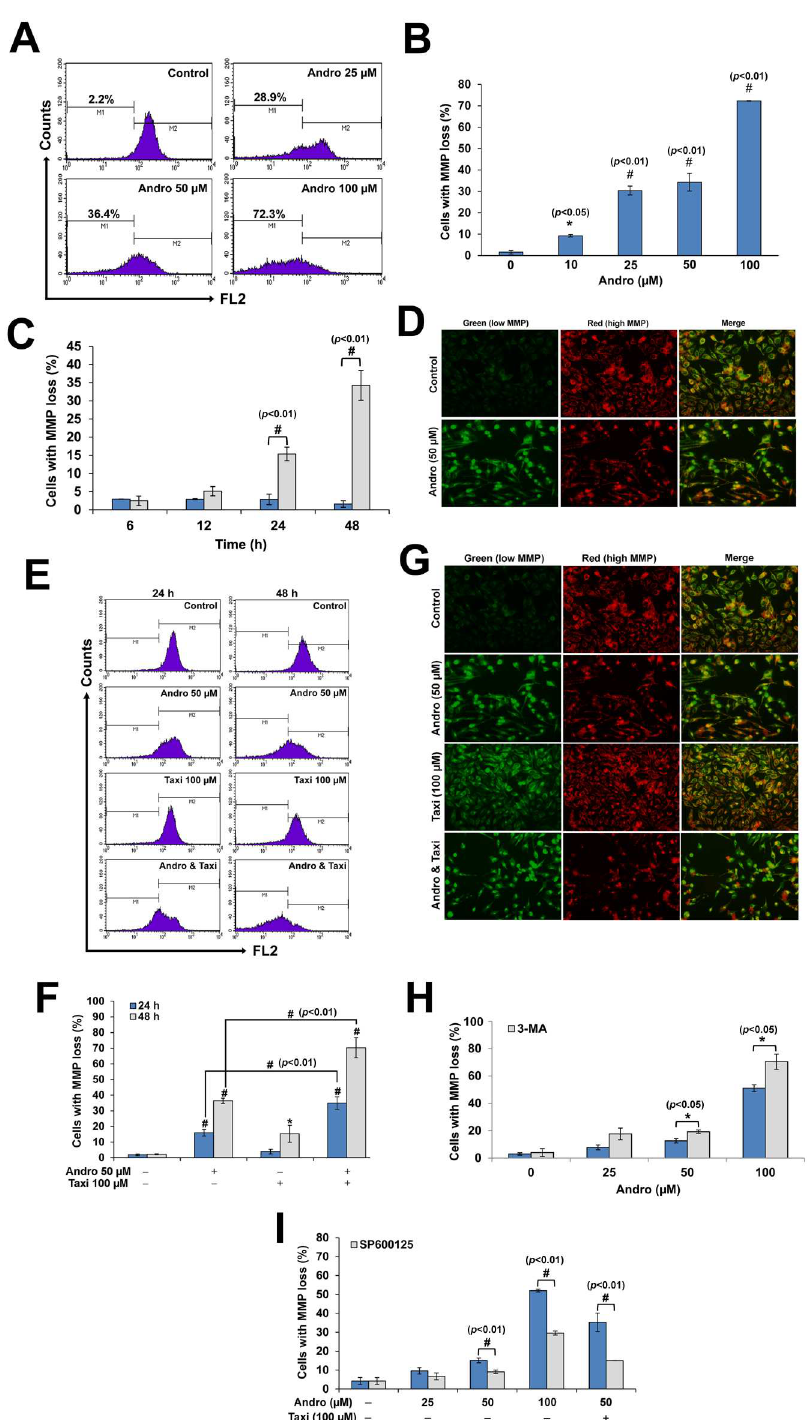
Fig 6. The effect of Andro alone or in combination with Taxi on MMP loss in HeLa cells. (A) A representative flow cytometric histograms showingthe loss in MMP (decrease in FL2 fluorescence) in HeLa cells treated with different concentrations of Andro for 48 h and stained with JC-1. (B) The percentageof cells with MMP loss in HeLa cells treated with different concentrations of Andro for 48 h. (C) The percentage of cells with MMP loss in HeLa cells treated with 50 μ M Andro for different time points comparedto the control. Results are representedas mean ± SD (n = 3). (D) Immunofluorescence micrographs of HeLa cells